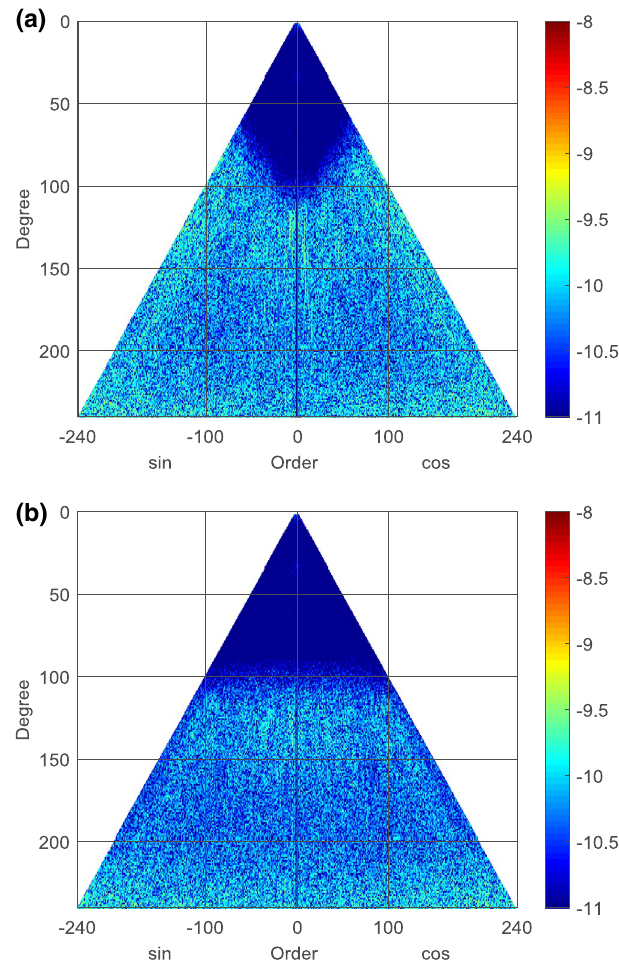
Figure 2. Spherical harmonic coefficients differences between I3GG and the existing gravity field models: ( a ) EGM2008 ( b ) EIGEN-5C, provide as absolute values in logarithmic scale ( log 10